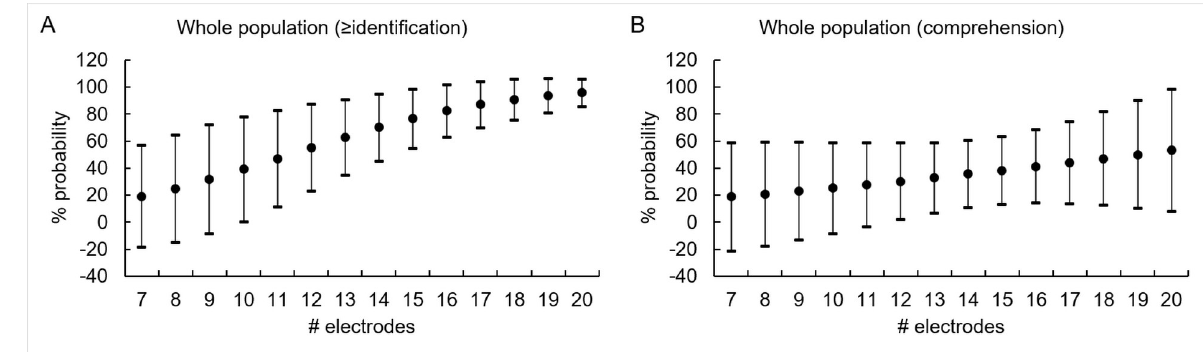
Fig 4. Median percentage and 95% confidence interval of perceptual results. A: Probability of closed-set word identification (Level 2) as a function of the number of active electrodes, across all ABI patients. The percentages increase non-linearly and the 95% confidence intervals narrow as the number of active electrodes increases. B: Probability of open-set word and sentence recognition (Level 3) as a function of the number of active electrodes, across all ABI patients. While the median percentage increases slowly with the number of active electrodes, the 95% confidence interval remains similarly wide across the number of electrodes, indicating considerable inter-subject variability. #,